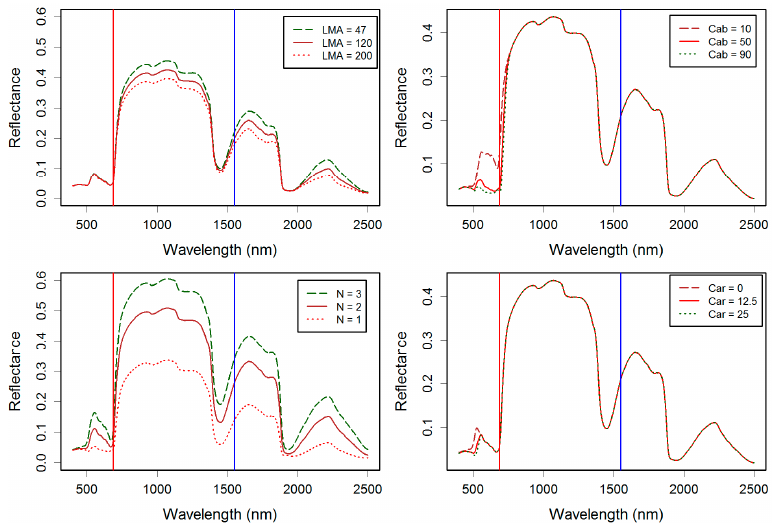
Figure 8. Leaf reflectance spectra between 400 nm and 2500 nm modeled with the PROSPECT-5 model for leaf mass per unit area (LMA) ranging between 47 g/m 2 and 200 g/m 2 , chlorophyll content (Cab) ranging between 10 µ g/cm 2 and 90 µ g/cm 2 , leaf structural parameter (N) ranging between 1 and 3, and carotenoid content ranging between 0 µ g/cm 2 and 25 µ g/cm 2 based on Ceccatto et al. [28]. The red and blue bars represent the laser wavelengths of 690 nm and 1550 nm, respectively.